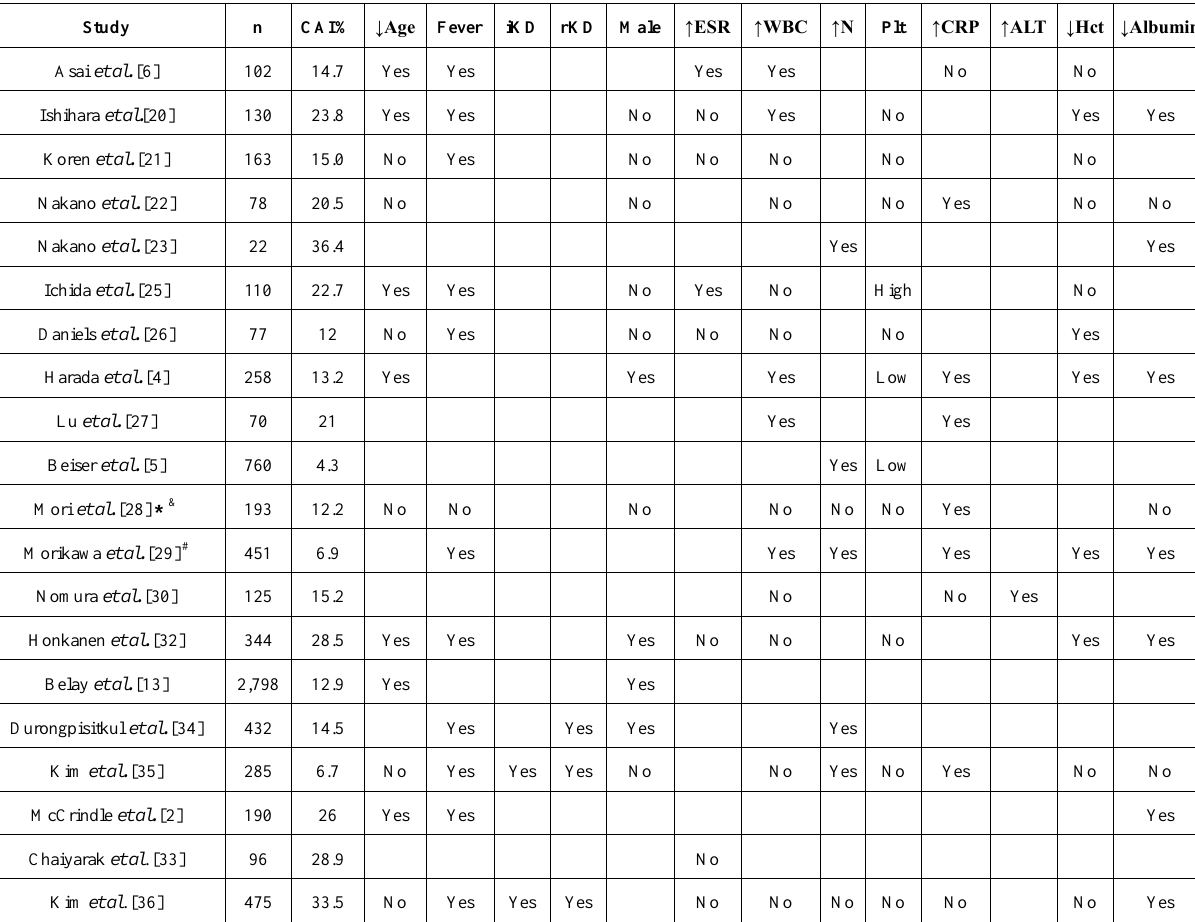
Table 3. Variability in reported clinical and laboratory findings associated with coronary artery involvement in Kawasaki disease. Yes indicates presence of association with coronary involvement; No, absence of association; Up and down arrows indicate high or low values of the laboratory parameters; Fever indicates longer duration of fever. In the platelets column, High indicates association of coronary involvement with a higher platelet count and Low indicates association of coronary involvement with a low platelet count; Abbreviations: CAI, coronary artery involvement; KD, Kawasaki disease; iKD, incomplete KD; rKD, refractory KD; ESR, erythrocyte sedimentation rate; WBC, white blood cell; N, Neutrophil count; Plt, platelet count; CRP, C-reactive protein; ALT, alanine aminotransferase; Hct, hematocrit/hemoglobin. * In this study the white blood cell count, platelet count and C-reactive protein significantly increased after intravenous immunoglobulin in patients